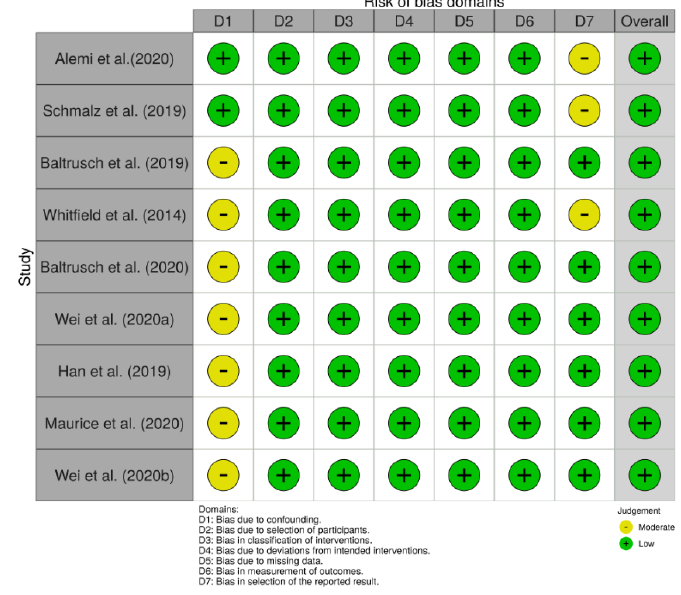
Figure 2. The risk of bias summary: authors’ judgements for each included study and for each considered domain .